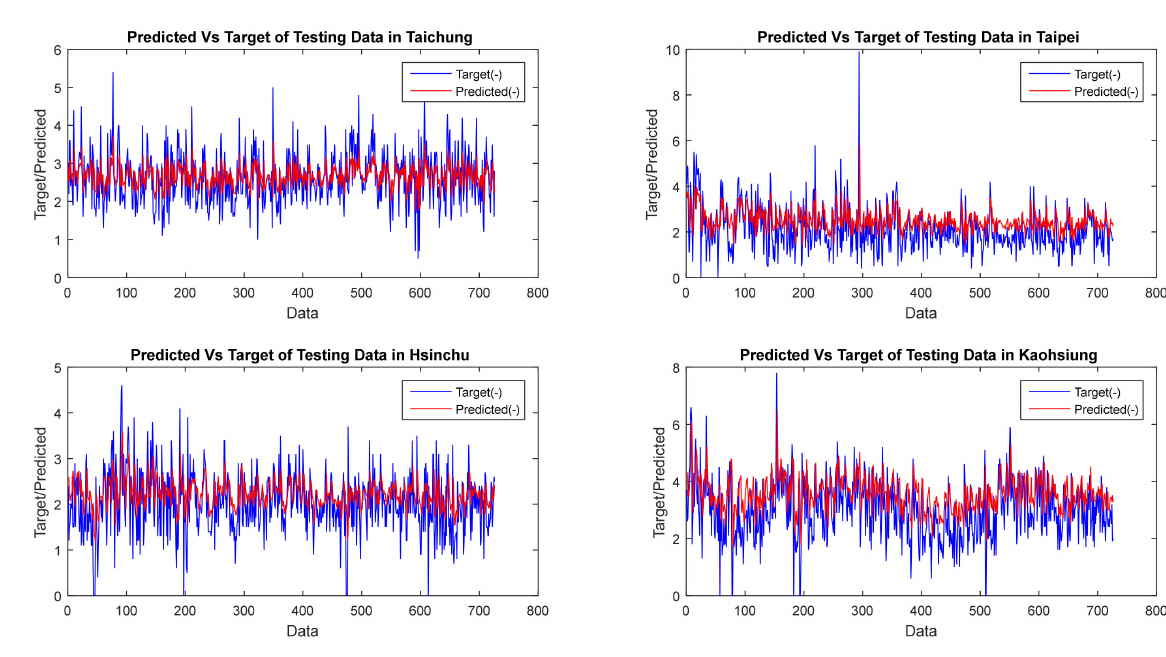
Figure 6. SO 2 GSTAR(2) CFNN PSO.